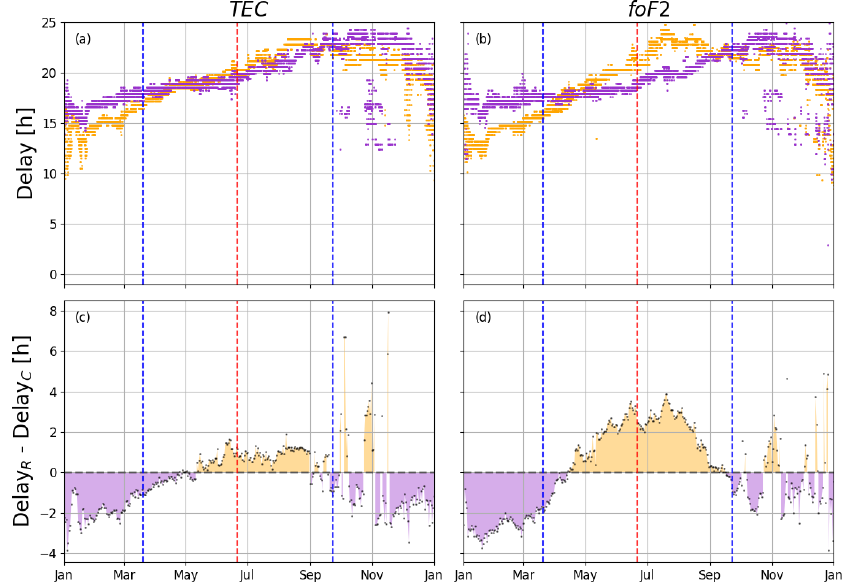
Figure 12. Superposed epoch plots for the delay (a, b) and difference in delays (c, d) for the ionospheric parameters TEC and fo F2 with integrated EVE fluxes (6 to 105nm) for Rome (orange) and Canberra (purple). The temporal resolution is 1h. Equinoxes are marked with the blue dashed lines, and the solstice is marked with the red dashed line.